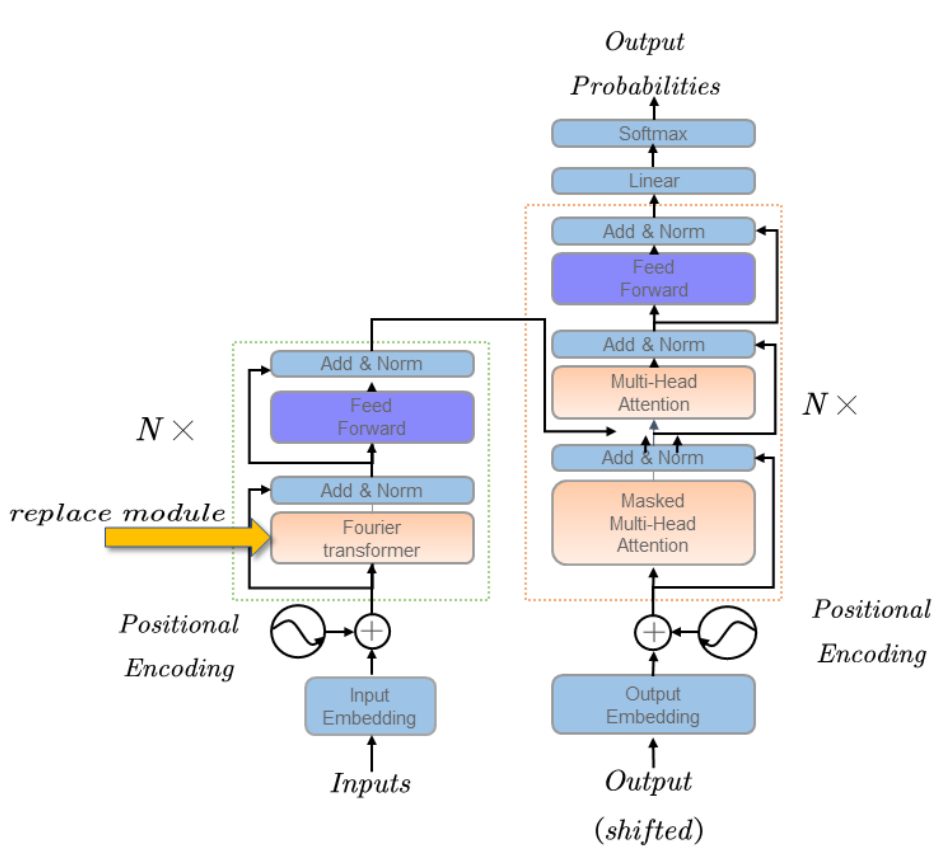
Figure 3. Linear transformer structure